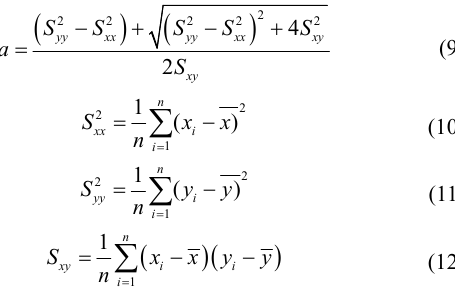
The experiments are divided into three groups, Dataset 1, Dataset 2 and Dataset 3, and all groups included three sets of experiments. Landsat-8 OLI is selected as the reference image in Dataset 1 and 3, and Dataset 2 selects the Sentinel-2 MSI as the reference image. The study area images should be selected on the same date as much as possible to ensure that the